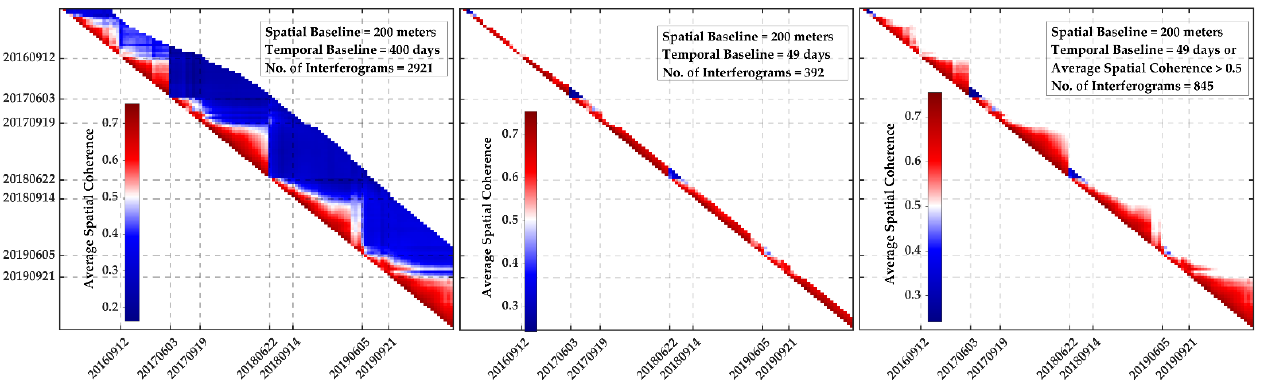
Figure 5. Average interferometric coherence coefficients from 2015 to 2020, The vertical axis represents the time span of the primary images and the horizontal axis represents the time span of the secondary images. The color values of pixels represent the ASC of the interferograms.